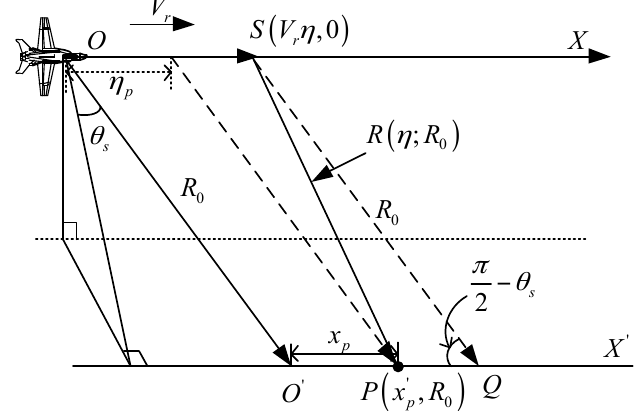
Figure 1. Geometry of squint synthetic aperture radar (SAR). The geometry of a general squint SAR provides the model of the signal acquisition. The radar flies along the X-axis with the velocity of V r . OO (cid:48) is the vector of the beam illumination. The angle of which away from the X-axis is ( π where θ s is the squint angle. R 0 is the slant range between the sensor and the boresight